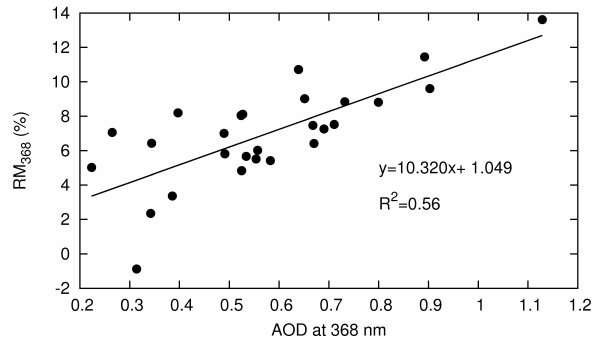
Fig. 4. The scatter diagram of the RM differences (%) at 368nm versus the in-situ mean total optical depth (aerosol plus cloud) at 368nm for the 27 UVMRP. Also shown are the respective linear regression function and correlation coefficient, with the fitting line for total optical depth at 368nm ( solid ).